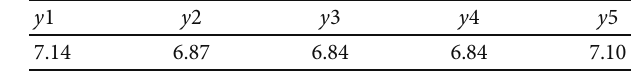
Table 13: Measured output group